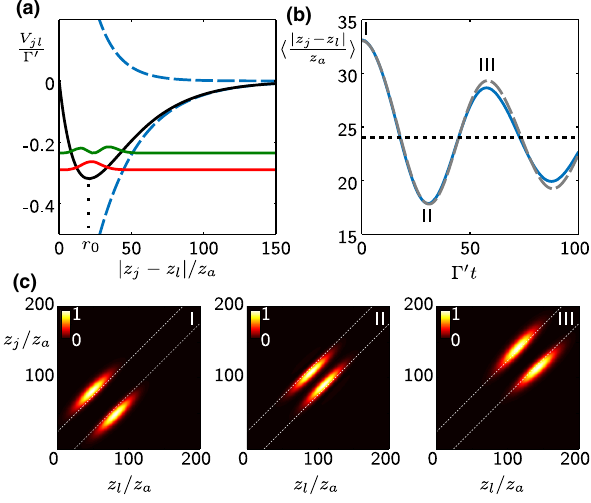
FIG. 4. (a) The photonic-crystal-mediated atomic interac- − z V ð z tions result in an interaction potential V jl ¼ j l Þ¼ − z − exp ð − j z − z G ½ exp ð − j z =L =L l Þ(cid:2) (black solid line) for j l j u Þ j l j − z polaritons separated by distance j z . The interaction poten- j l j tial is the sum of the contribution from the lower and upper photonic crystal band edges (dashed blue lines) that have length 15 z scales L and L l ¼ 30 z and strength G ¼ 1 . 28 Γ 0 , which u ¼ a a in this case leads to a minimum at a finite atomic separation r 0 ∼ 21 z . Loss resulting from the photonic-crystal-mediated a interactions is calculated assuming a cooperativity of C λ ¼ 24000 . The amplitudes j ψ ð r Þj 2 (arbitrary units) of the two lowest bound-state wave functions are shown for Δ 2 . 5 Γ 0 , Ω ¼ Γ 0 , and Γ 2 Γ 0 . (b) For two polaritons 1 D ¼ M ¼ propagating with this interaction, a state initiated with a wave function matching that of the ground state, but offset from the ground-state separation at time t ¼ 0 , oscillates in time in the relative coordinate. The oscillation of the expectation value of polariton separation about the ground-state separation (about 24 z , indicated by the dotted line) found by simulation the full a EIT system (solid line) is closely matched to the oscillation produced by the evolution of the effective Hamiltonian H rel ¼ − ð ℏ 2 =m Þð ∂ 2 = ∂ r 2 Þ − 2 ℏ V ð r Þ (dashed line). In this case, a full oscillation occurs after the polaritons travel an optical depth of D ¼ 250 using the parameters in (a). (c) Spin population j ψ ss j 2 j;l (arbitrary units) as the initially offset pair of polaritons propagate through the atomic ensemble, with the dotted line indicating the ground-state separation of the two polaritons. The frames I, II, and III correspond to the turning points of the oscillation marked in